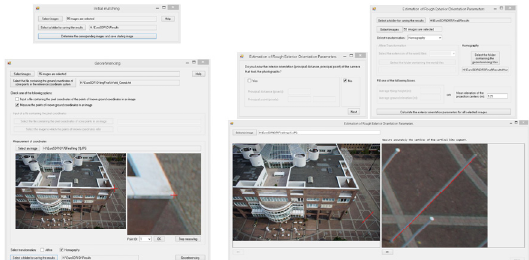
Figure 3. Developed software suite